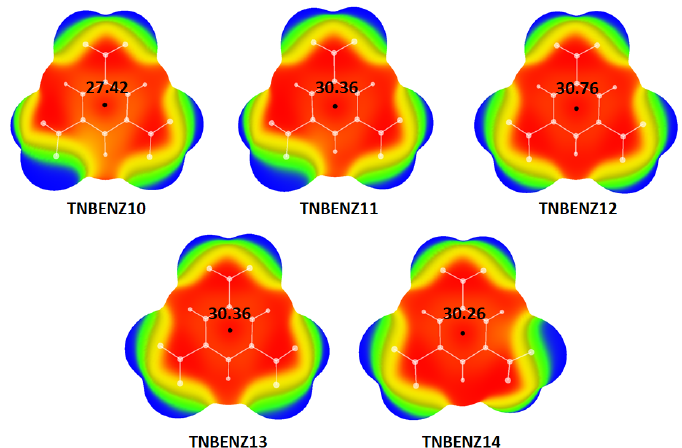
Figure 2. Electrostatic potential maps calculated for the geometries of TNT molecule found in crystal structures archieved in CSD. Color ranges (in kcal/mol): red, greater than 20.92, yellow, from 0.00 to 20.92, green, from − 6.99 to 0.00, and blue, more negative than 6.99. Calculated values of positive electrostatic potential above the central area of molec- ular surfaces are: 27.42 kcal/mol for TNBENZ10; 30.36 kcal/mol for TNBENZ11; 30.76 kcal/mol for TNBENZ12; 30.36 kcal/mol for TNBENZ13 and 30.26 kcal/mol for TNBENZ14. These values were compared to previously calculated values of electrostatic potential for computationally optimized geometry of TNB molecule (Table 1) [16]. Table 1. Total energies, V max deviations, and V max values in critical points above the centers of ni- troaromatic rings calculated for selected crystal structures containing TNB molecule. Structure V max 1 (kcal/mol) E (Hartree)